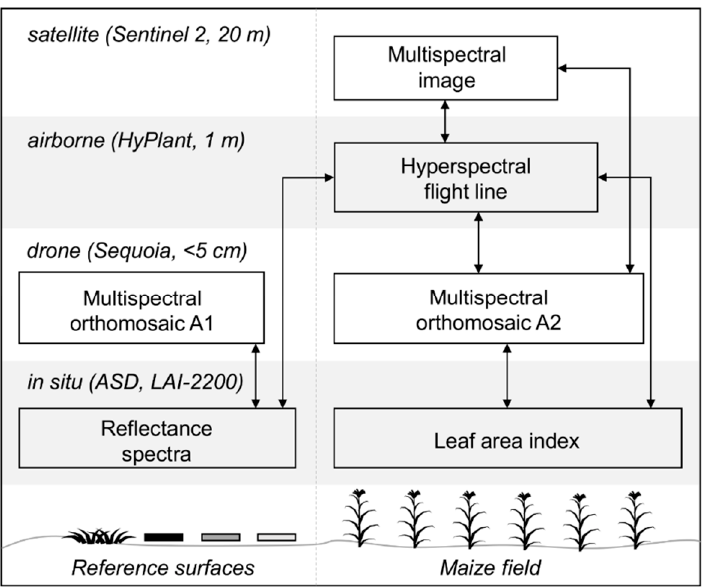
Figure 1. Overview of the multisource datasets, including details on spatial resolution, and comparison experiments performed. Arrows indicate which datasets are compared within this study.